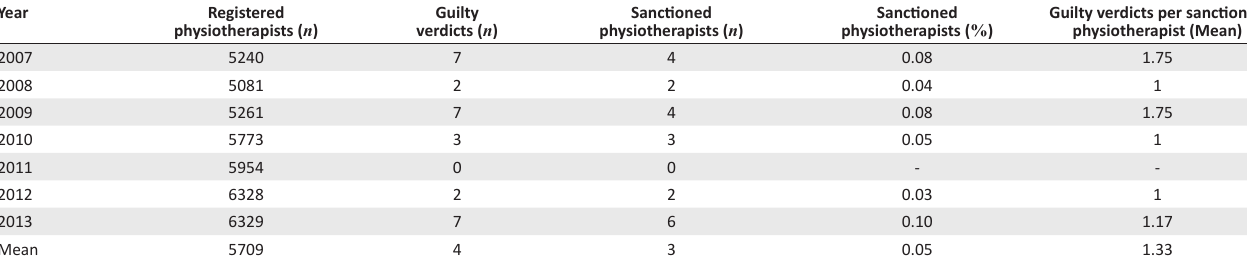
TABLE 1: Annual frequency of guilty verdicts against physiotherapists (2007–2013).